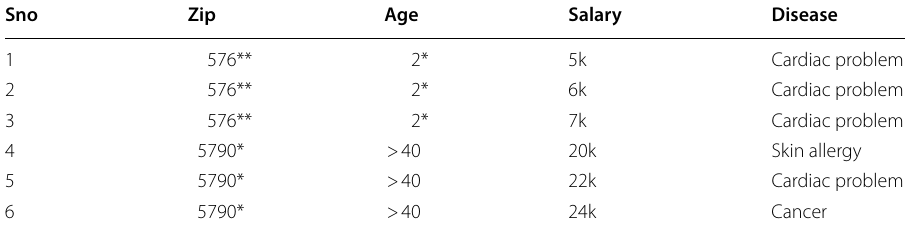
Table 3 L diversity privacy preservation